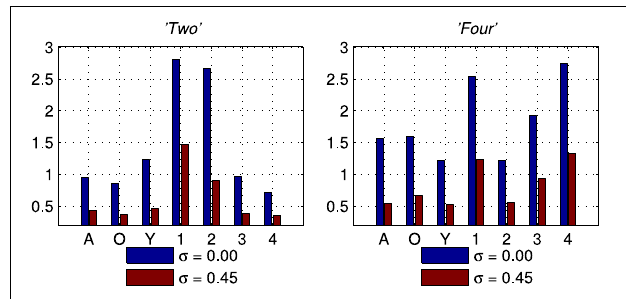
FIGURE 9 | Stimulus Specific Information results for two of the seven classes of stimuli, “Two” and “Four.” In Blue is the no noise ( σ = 0 . 00) condition and in Red the noisiest ( σ = 0 . 45) condition for